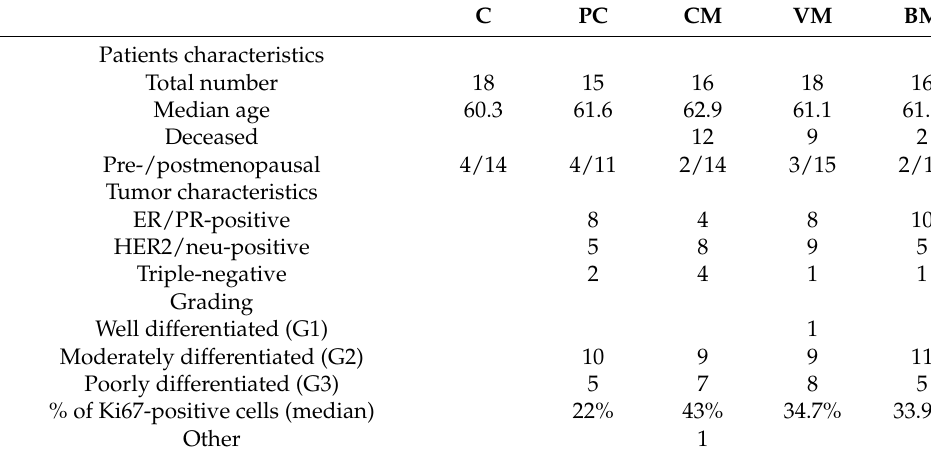
Table 1. Patient characteristics. Summary of clinical